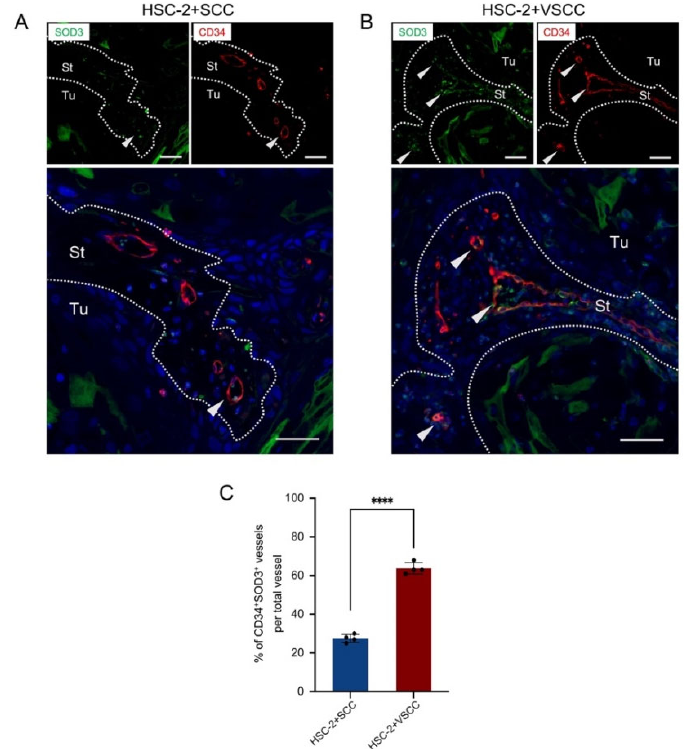
Figure 4. SOD3 + endothelial cells form the large vessels in low ‐ invasive VSCC stroma xenograft. ( A ) Representative images of double fluorescent IHC for SOD3 (green) and CD34 (red) in HSC ‐ 2+SCC xenograft. ( B ) Representative images of double fluorescent IHC for SOD3 (green) and CD34 (red) in HSC ‐ 2+VSCC xenograft. Nuclei are stained with DAPI. Arrowheads indicate double ‐ positive cells. Dotted lines represent the boundary of the tumor (Tu) and stroma (St) area. Scale bars: 50 μ m. ( C ) Rate of CD34 + SOD3 + vessels per total vessel. All the data are shown as mean ± SD. Statistical analyses were performed using Student’s t ‐ test; **** p < 0.0001.